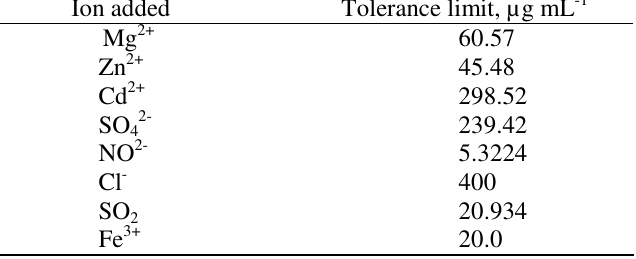
Table 2. Interference of foreign ions for the determination of 0.8 µ g mL sulphide.